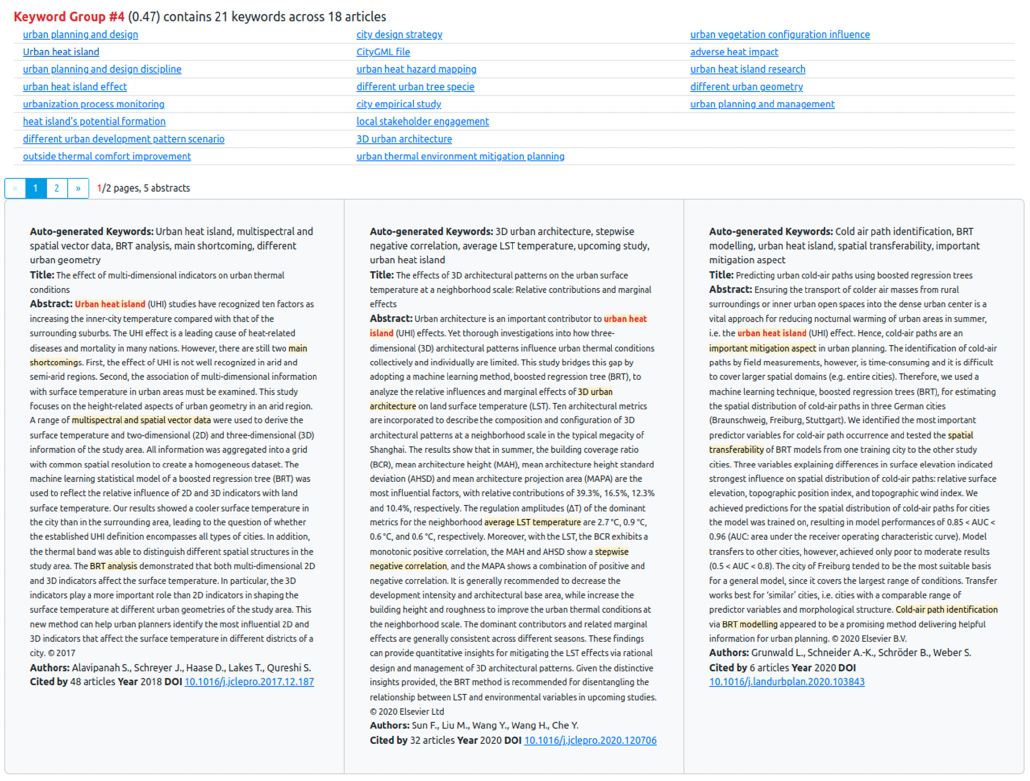
Figure 7. Keyword group visualization. By selecting the cluster #2, ( a ) displays a scatter chart of four keyword groups in blue, orange, green, and red in the left panel and the keyword examples of each keyword group in the right panel. ( b ) displays the keyword group #4, including the keywords in the top panel and abstracts in the bottom panel. Clicking a keyword group number, say #4, displays the visualization interface of an individual keyword group, as shown in Figure 7b, where all the keywords in the group are listed in the top panel. In this case, urban heat island , heat impact , and urban thermal environment is the common theme (or topic) revealed by this keyword group. Clicking on a keyword, say urban heat island , displays three abstracts in the bottom panel that contain the clicked keyword highlighted in orange. These results show keywords in this group have a low amount of overlapping terms, and most keywords share a certain similarity (such as adverse heat impact , urban heat hazard , and urban thermal environment ) but contain different words. The total processing time on our dataset (593 abstracts) is about 1.5 h, with each phase roughly 25 to 30 min on a 6-core computer with 16 GB memory. The software implemen- tation is listed in Supplementary Material and described in Appendix A. 5. Discussion